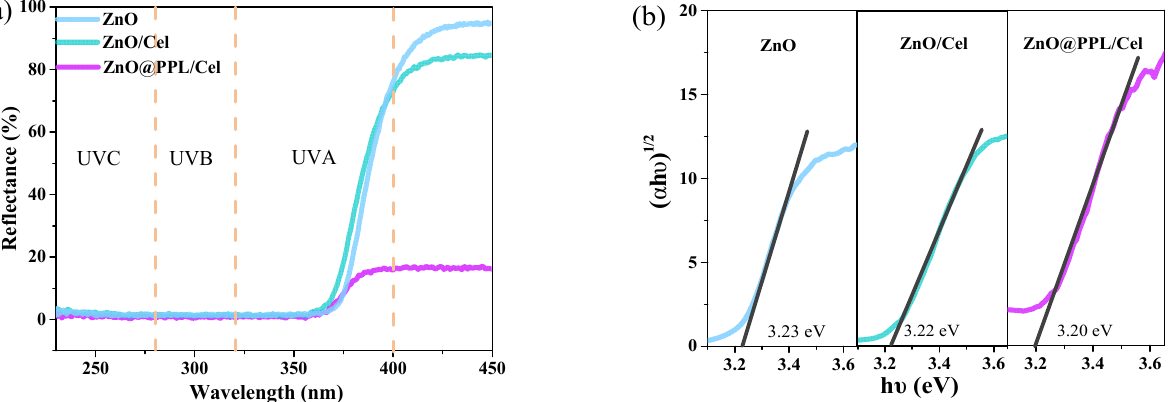
Figure 5. ( a ) Solid UV diffuse reflection spectroscopy, and ( b ) the first derivative of solid UV diffuse.